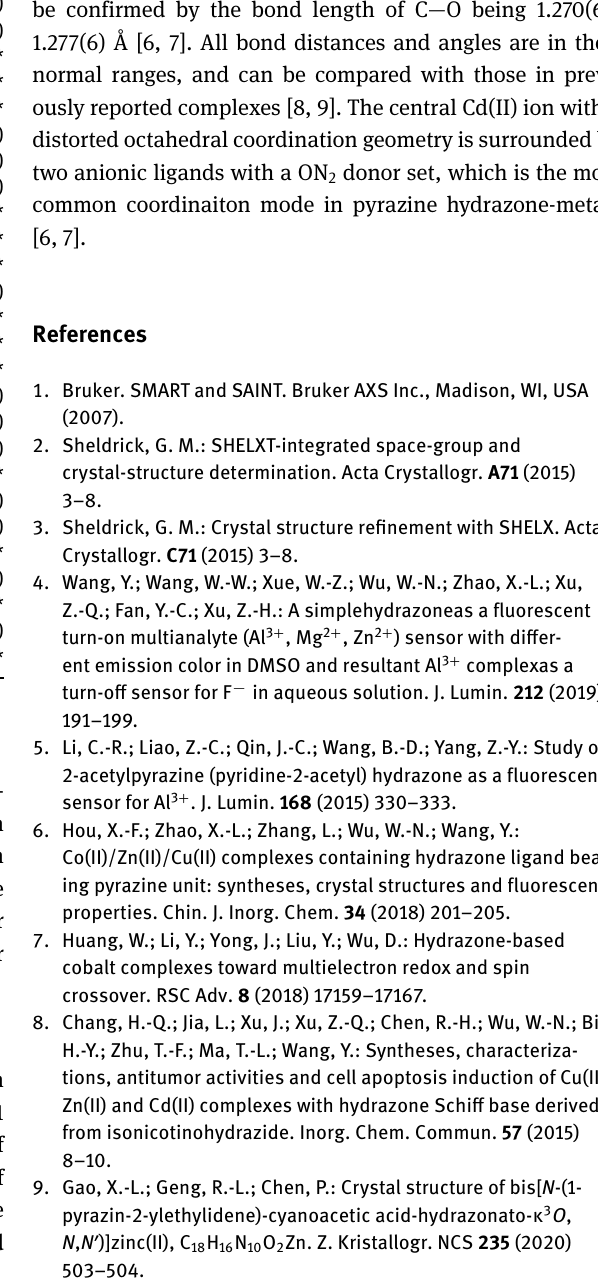
C21/C21A being 0.59/0.41. The hydrogen atoms for O3 atom of thecrystalwaterarenotaddedbecauseofitsoccupancyvalue being0.5.Theotherhydrogenatomswereplacedatcalculated positions and refined as riding